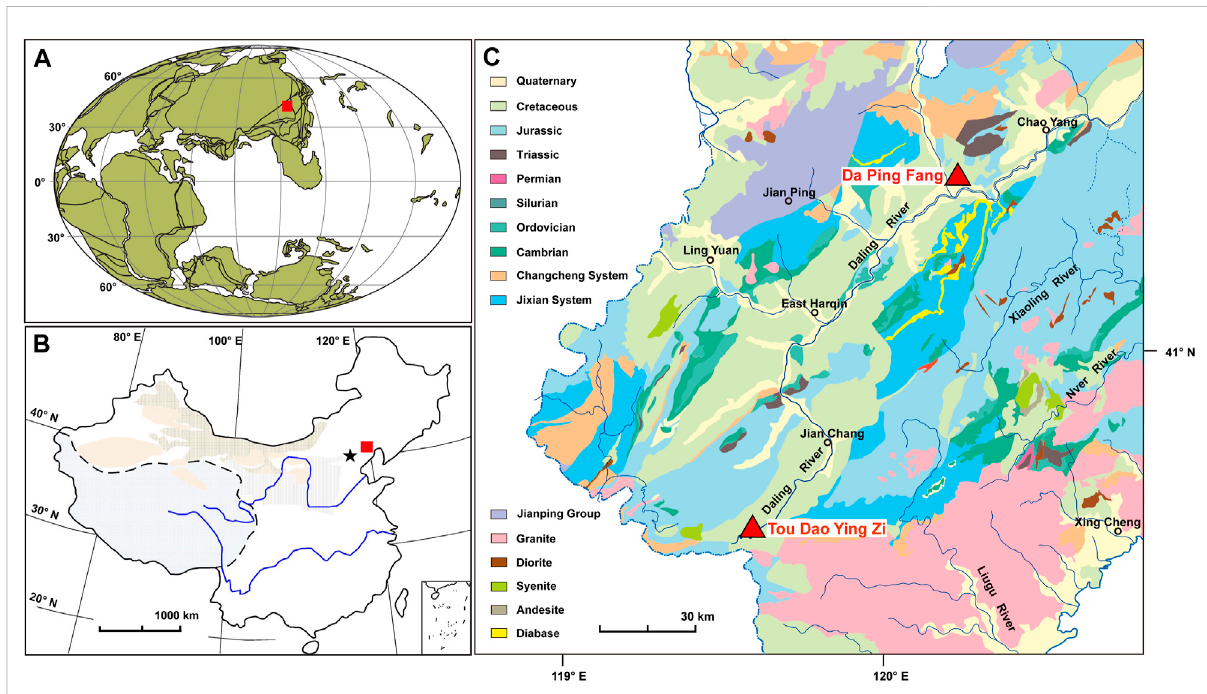
FIGURE 1 (A) Paleogeographic position (www.odsn.de) and (B) geographic position of the study area (red square); and (C) geological map of western Liaoning, China, and fossil sites in this study (red